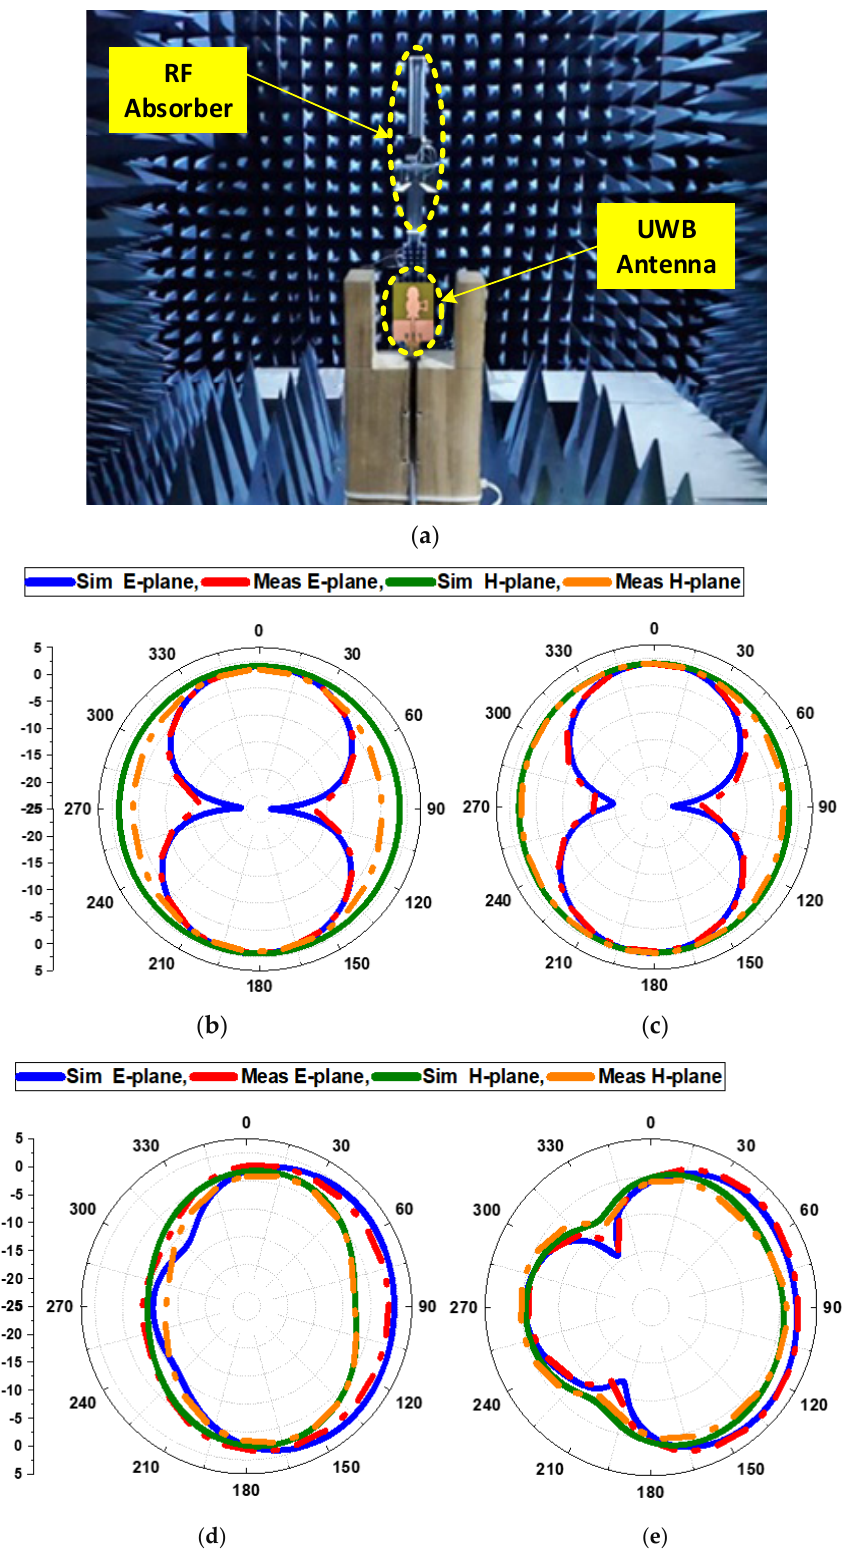
Figure 8. ( a ) Simulated and measured 2D radiation pattern setup inside chamber ( b ) at 3.5 GHz, ( c ) at 4.1 GHz, ( d ) at 8 GHz, ( e ) at 10.5 GHz.